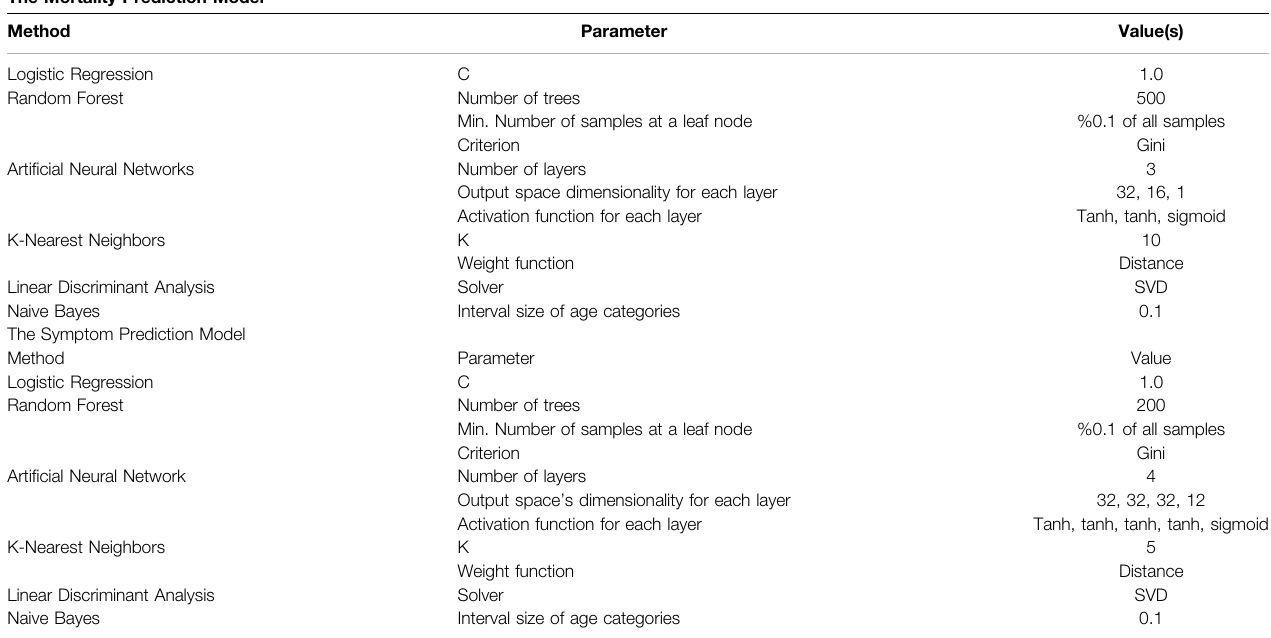
TABLE 4 | Machine learning methods and hyperparameters